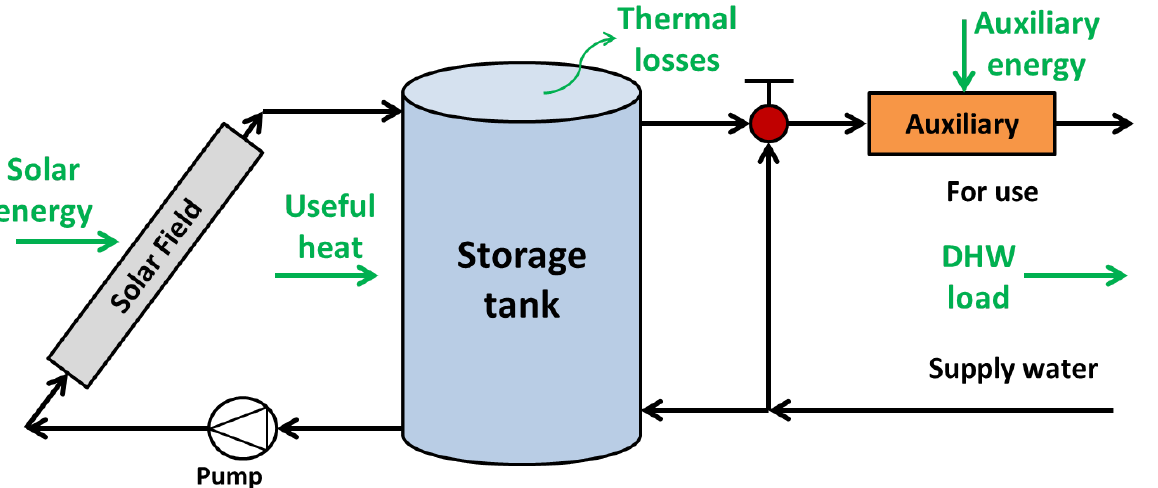
Figure 1. Simplistic presentation of the examined solar thermal system for DHW production.